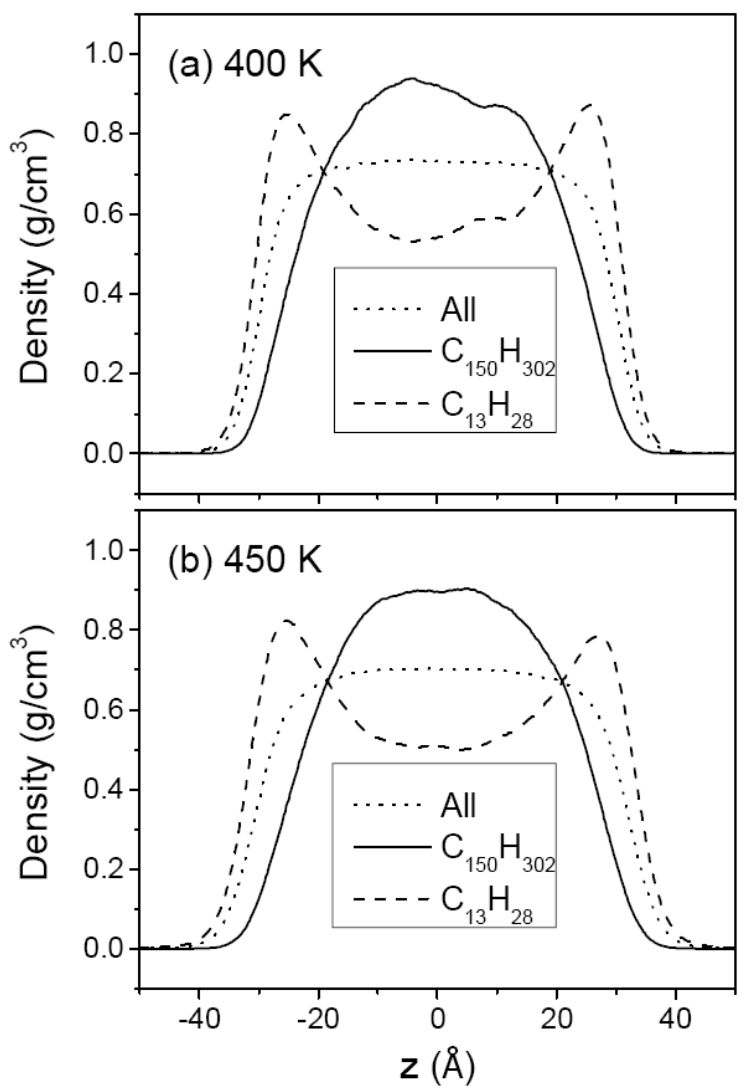
Figure 8. The density profiles of (C 13 H 28 + C 150 H 302 ) mixture melt film at 400 ( a ) and 450 K ( b ). The dotted line is the density of all chains, the solid line is the all-atom density profile of C 150 H 302 , and the dashed line is that of C 13 H 28 . The density of each species is normalized to that of all chain atoms; see the caption for Figure 3.